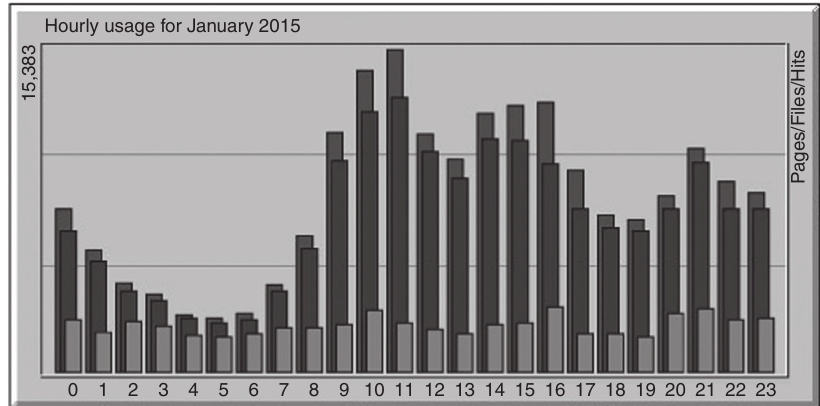
Figure 6. Hourly usage for January